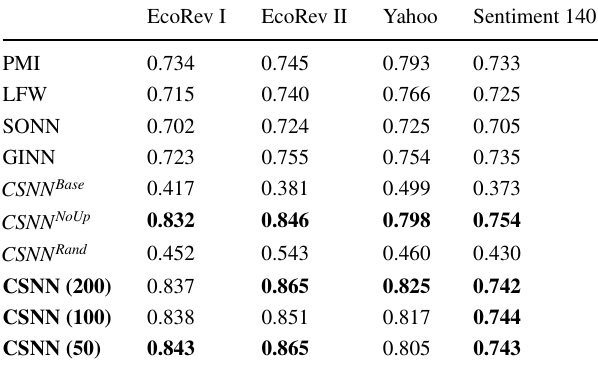
Table 5 Evaluation for explanation ability in GIL (Pearson correla-